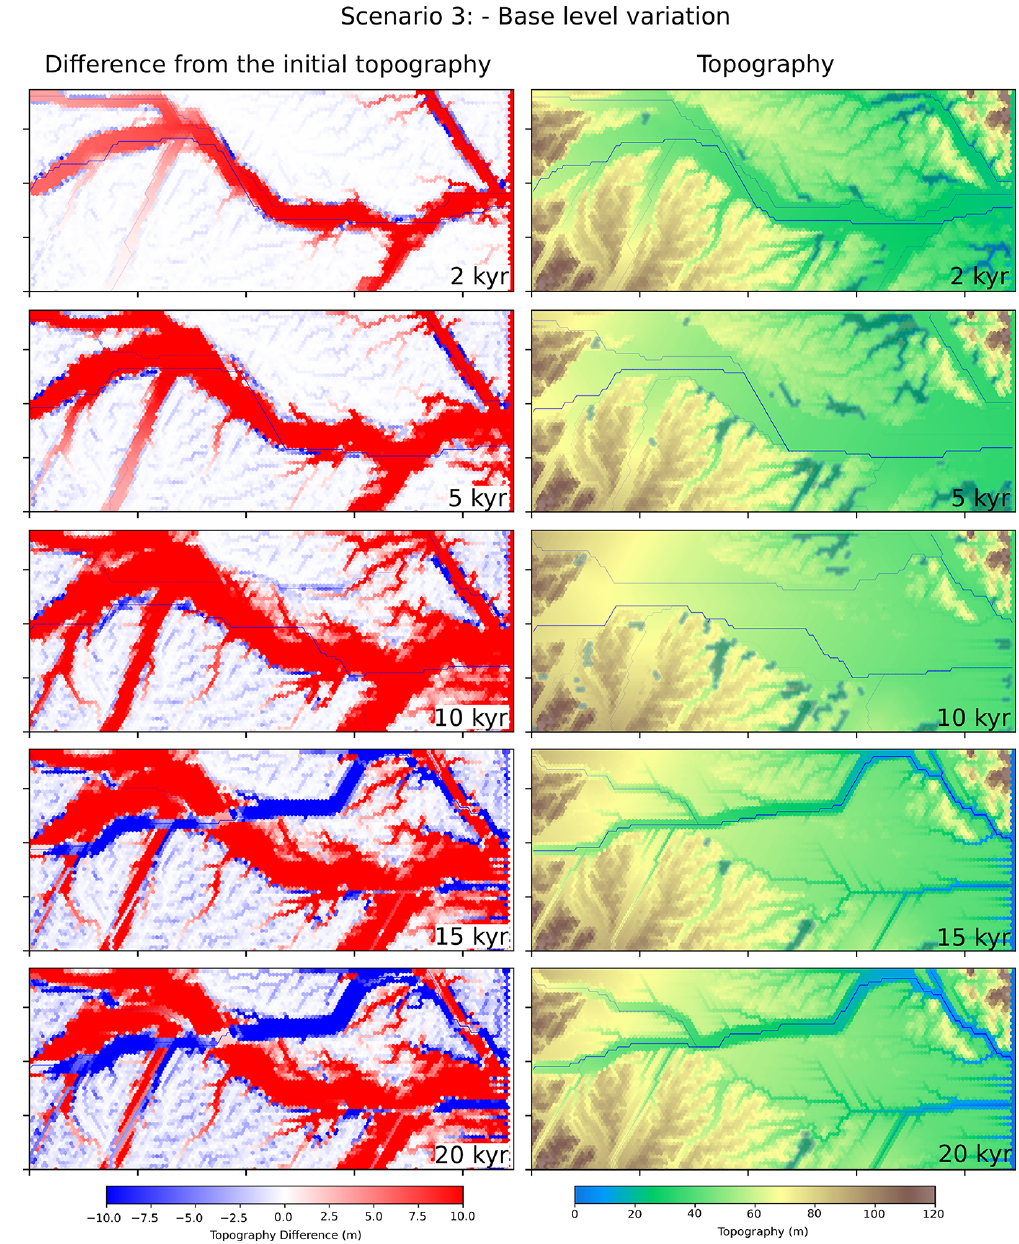
Figure 6. Model results showing the landscape evolution of scenario 3. The model water input is constant and equal to the current water input. The left panels show the difference of the model topography in relation to the initial topography, with colors saturated in red for values in elevation differences higher than 10m and in blue for values below − 10m. The right column shows the topography itself. The occasional blue stains on the map represent lakes (local